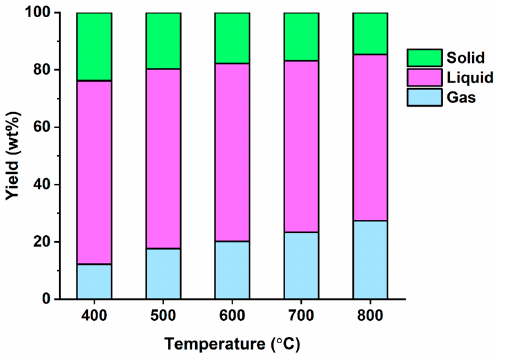
Figure 1. Mass balance of pyrolysate made from DJW without Na 2 CO 3 as a function of pyrolysis temperature. Average values of triplicate are reported with and standard deviations of the average values of 3–4%.